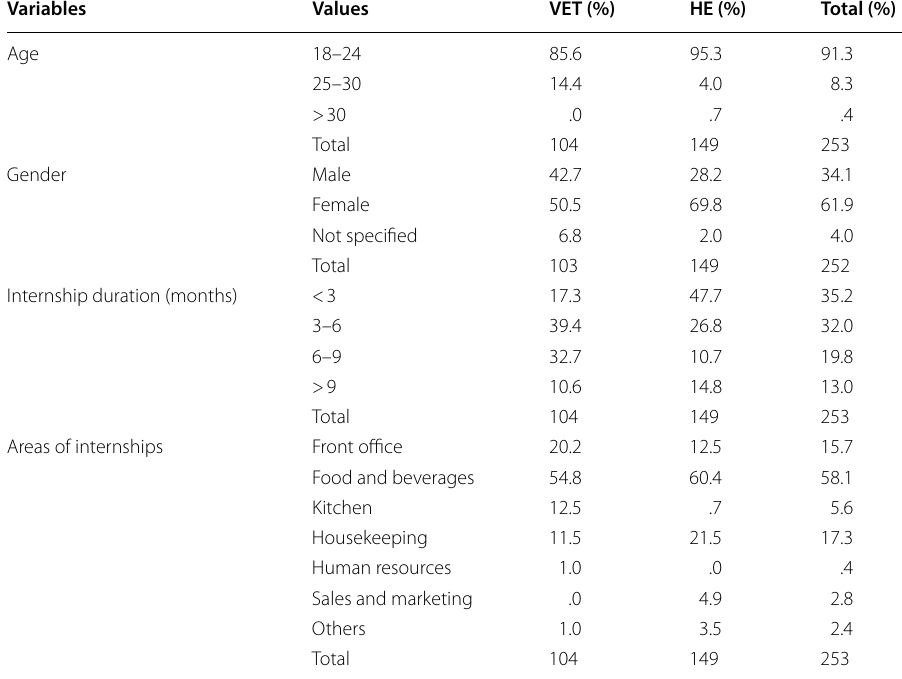
Table 4 Background and demographic characteristics of 253 participants Variables